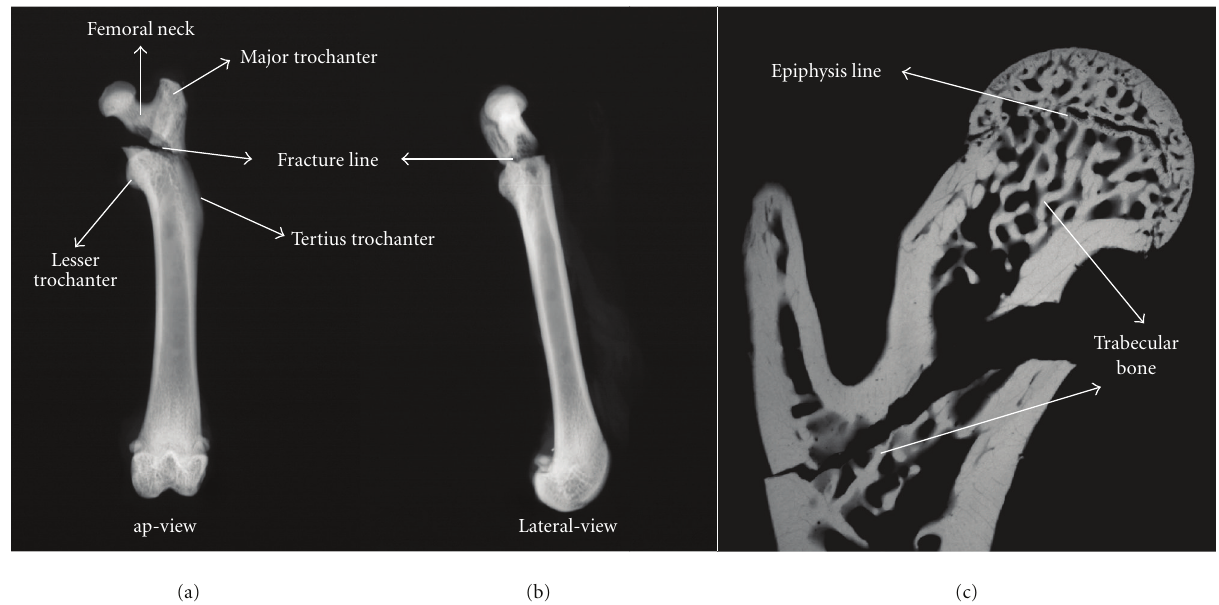
Figure 1: Radiographs of proximal rat femurs after breaking test. (a) Anterior-posterior view (ap-view) of the reversed trochanteric fracture of rat femur (type A3 fracture according to AO classification).(b) Lateral view. (c) The figure shows the microarchitecture (microradiograph of sagittal section) of proximal femur of Sprague-Dawley rat. Please note the fracture line and the content of the trabecular bone in this area.